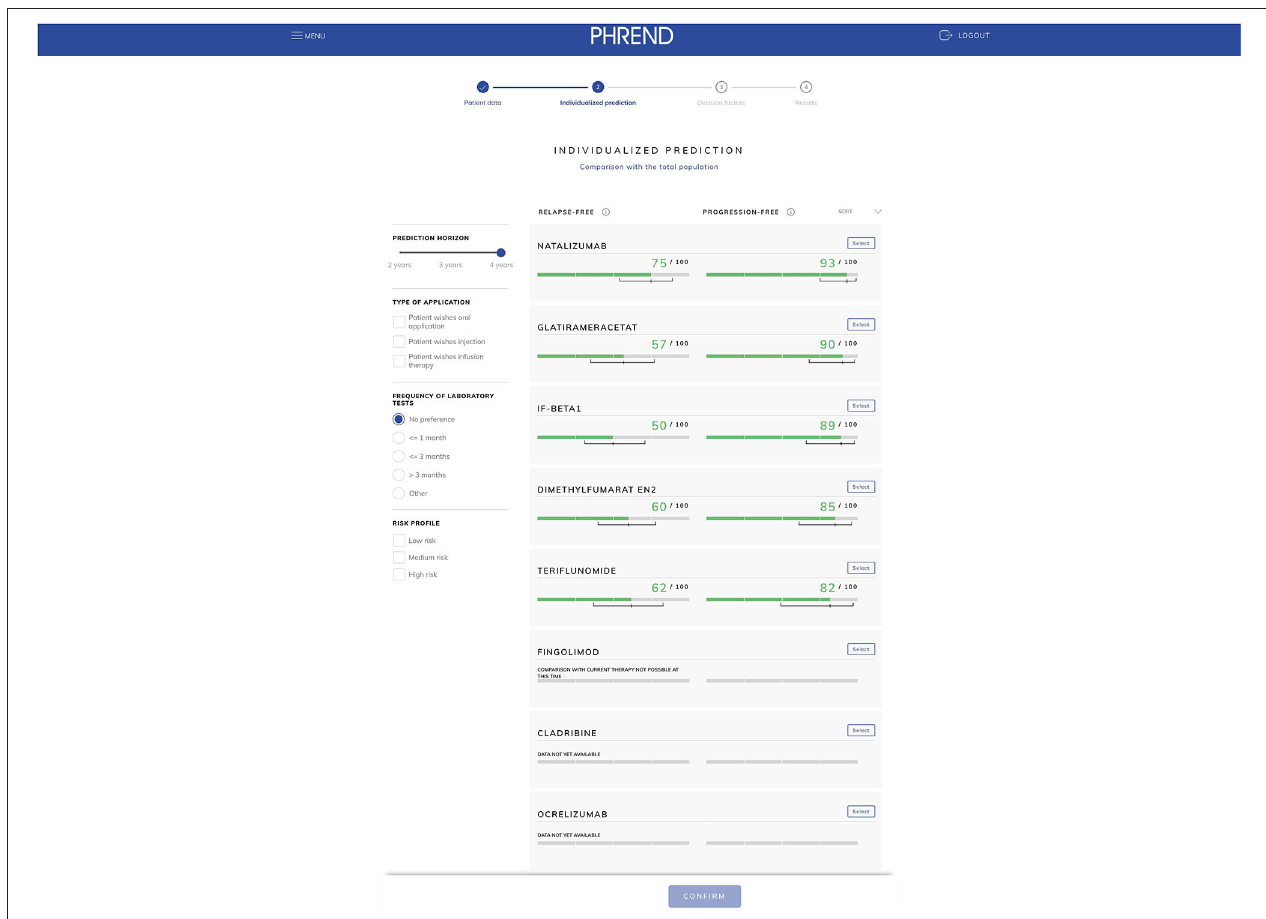
FIGURE 3 | PHREND (Predictive Healthcare with Real-world Evidence for Neurological Disorders): example of an individualized treatment prognosis.